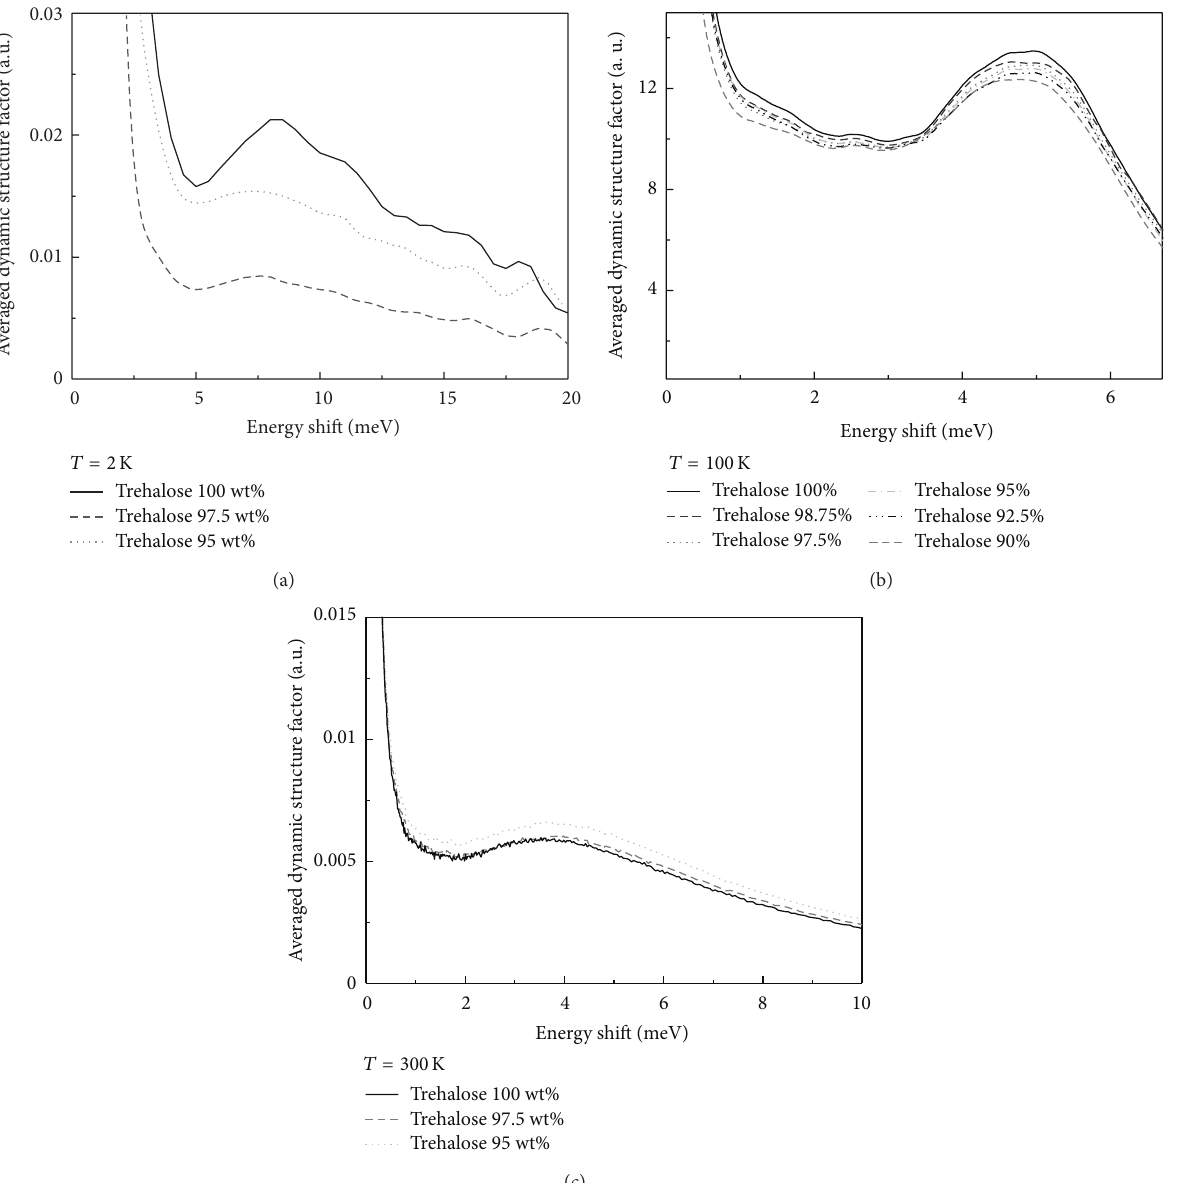
Figure 1: Averaged dynamic structure factor for trehalose/glycerol mixtures, obtained by adding up the spectra at different 𝑄 , as a function of the energy shift at (a) T = 2 K by IN4, (b) T = 100K by OSIRIS, and (c) T = 300 K by